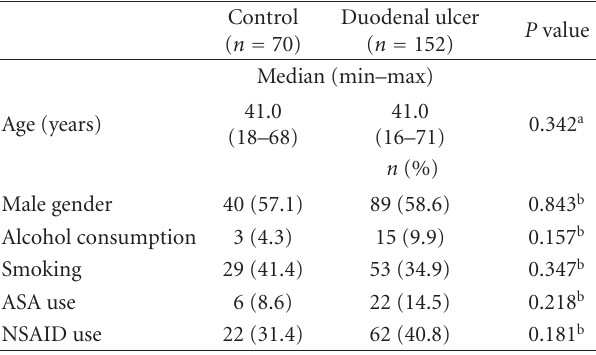
Table 1: Demographic features and risk in the study groups.